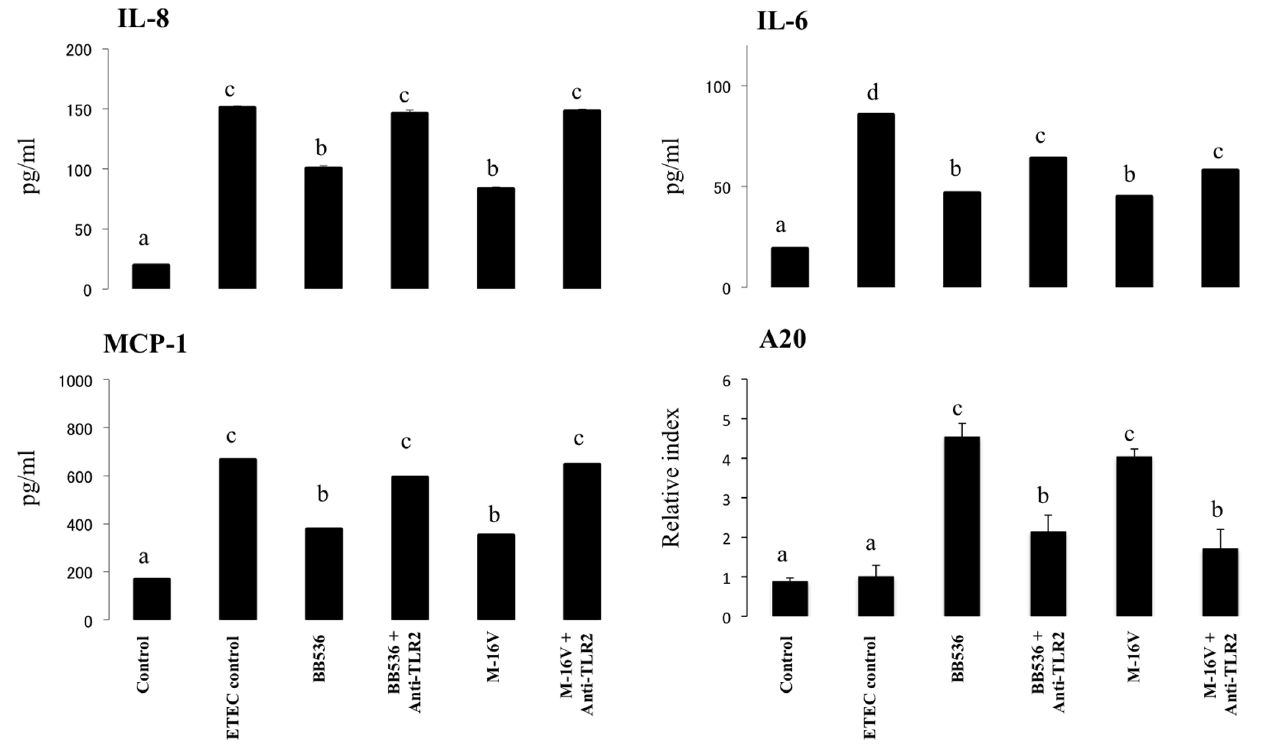
Figure 6. Role of TLR2 in the immunomodulatory effect of Bifidobacteriumlongum BB536 and Bifidobacteriumbreve M-16V in porcine intestinal epithelial (PIE) cells. PIE cells were pre-treated with BB536 or M-16V strains in the presence or absence of anti-TLR2 antibodies. Untreated PIE cells were used as controls. PIE cells were stimulated with heat-stable Enterotoxigenic Escherichia coli (ETEC) pathogen-associated molecular patterns (PAMPs), and then the expression of A20 mRNA levels and MCP-1, IL-6, and IL-8 protein levels were studied at 12 h post- stimulation. The results represent four independent experiments. Different letters indicate significant differences (P , 0.05).